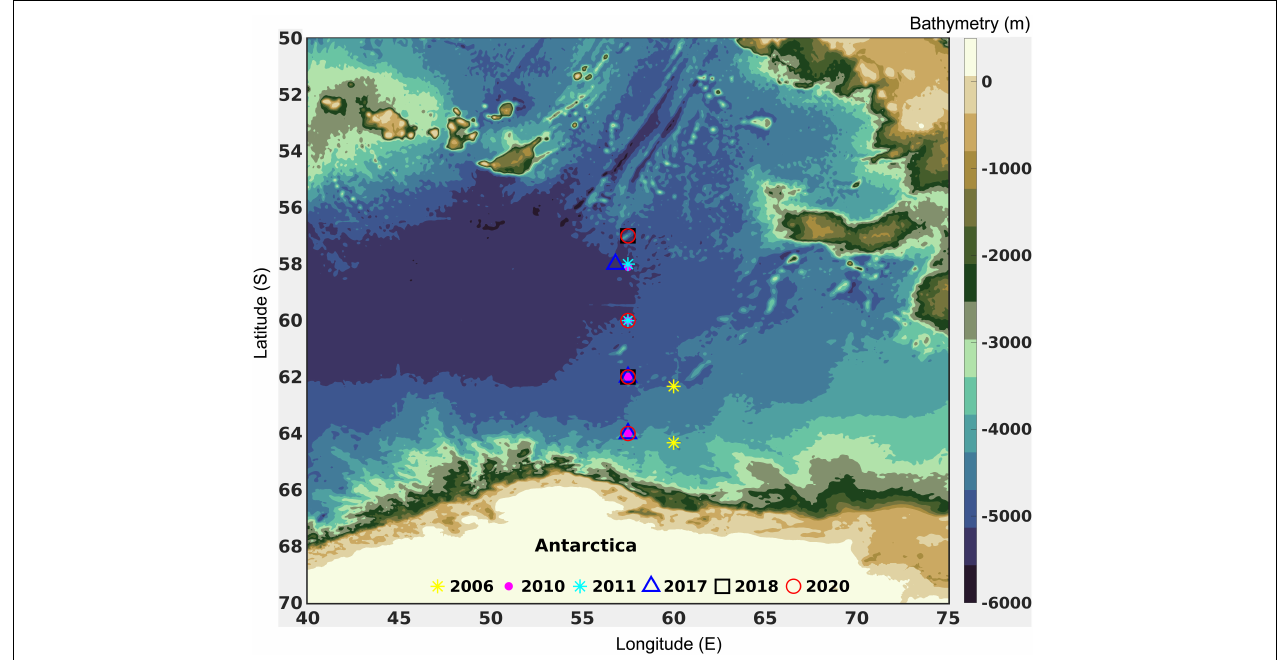
FIGURE 1 | The Conductivity, Temperature, Depth (CTD) station locations for different years from 2006 to 2020 are overlaid on the ETOPO1 bathymetric map (Amante and Eakins, 2009).